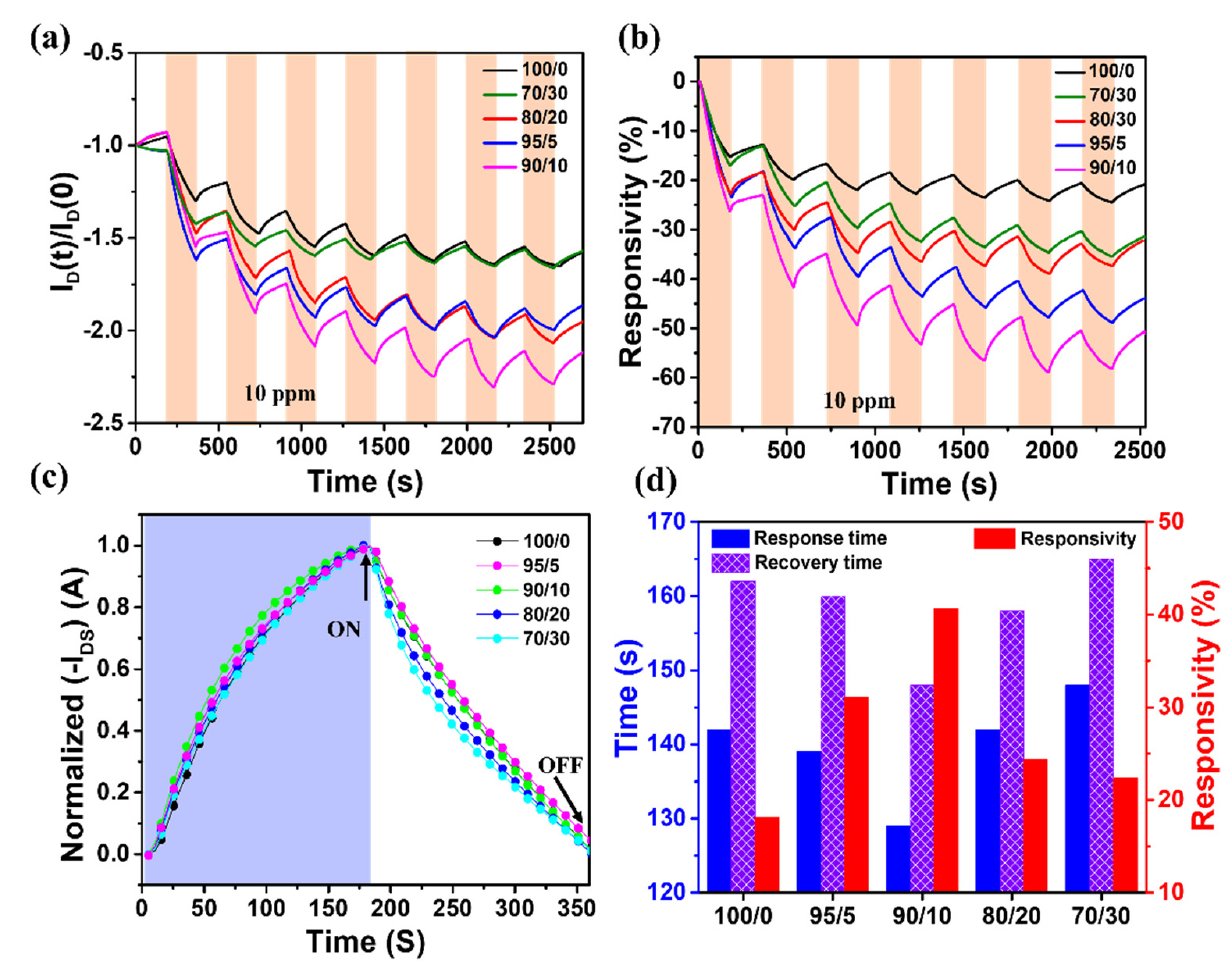
Figure 7. ( a ) Changes in the drain current of the P3HT/g-C 3 N 4 film − based OFET sensors and ( b ) the real − time response of the corresponding OFET sensors upon exposure to 10 ppm NO and synthetic dry air. ( c ) Normalized drain currents and ( d ) corresponding response/recovery times (left axis) and responsivity (right axis) of the OFET sensors (V DS = − 40 V, V GS = − 10 V).